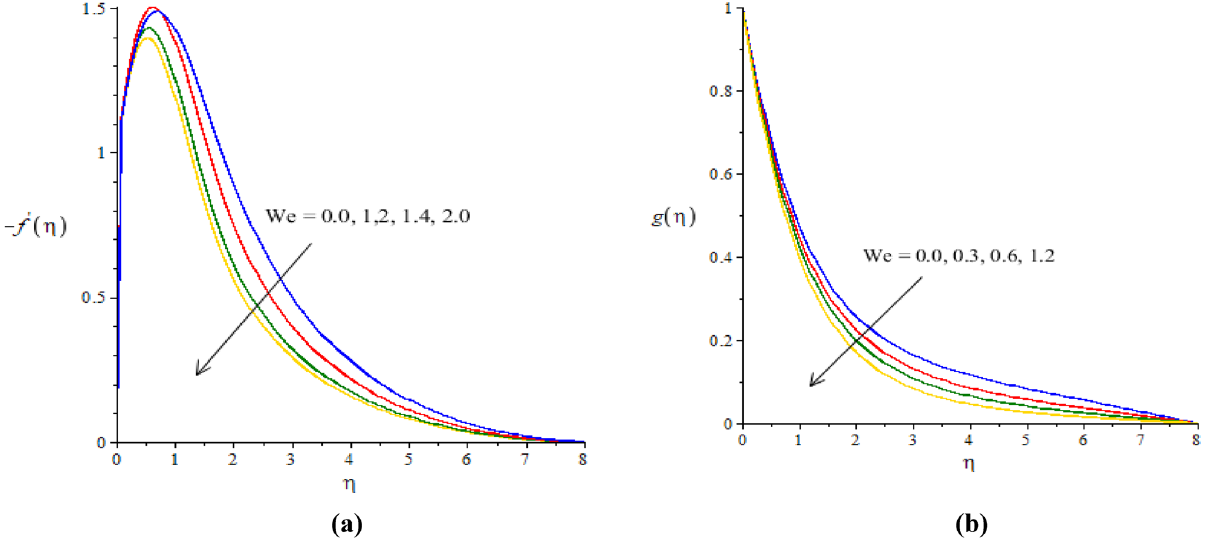
Figure 3. (a, b) The graphical view of velocities versus We